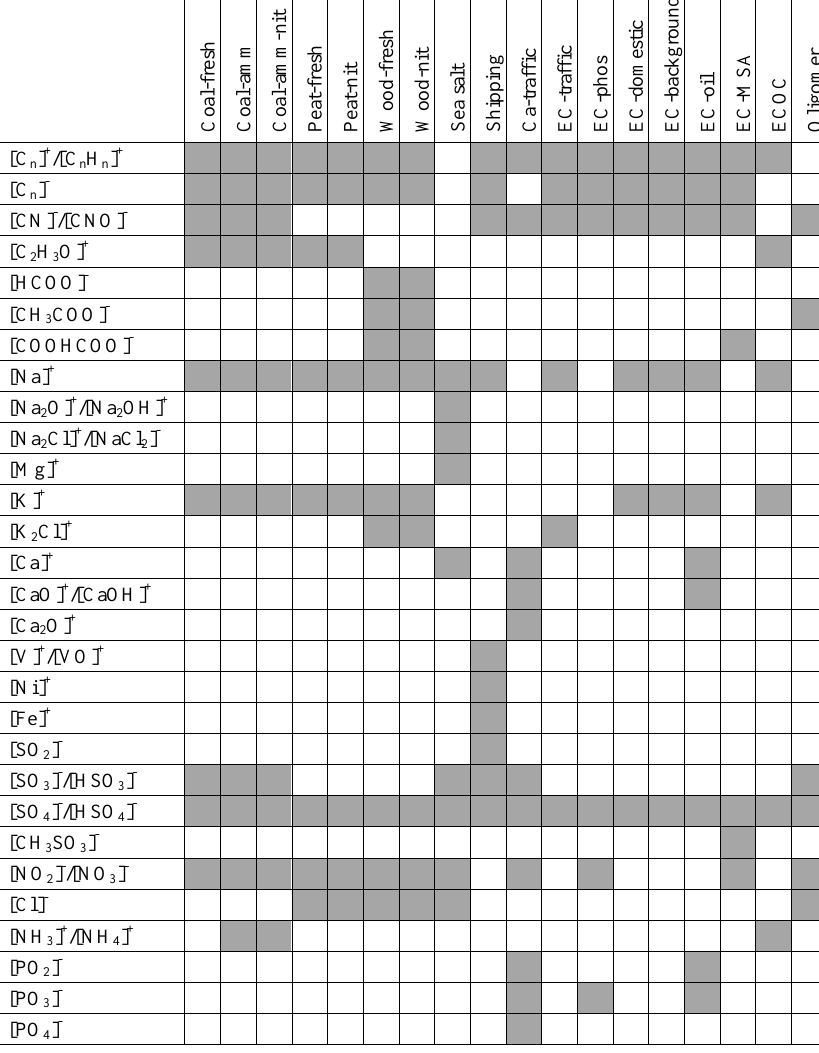
Table 1: Ions observed in mass spectra for each ATOFMS particle class, represented by shaded areas.